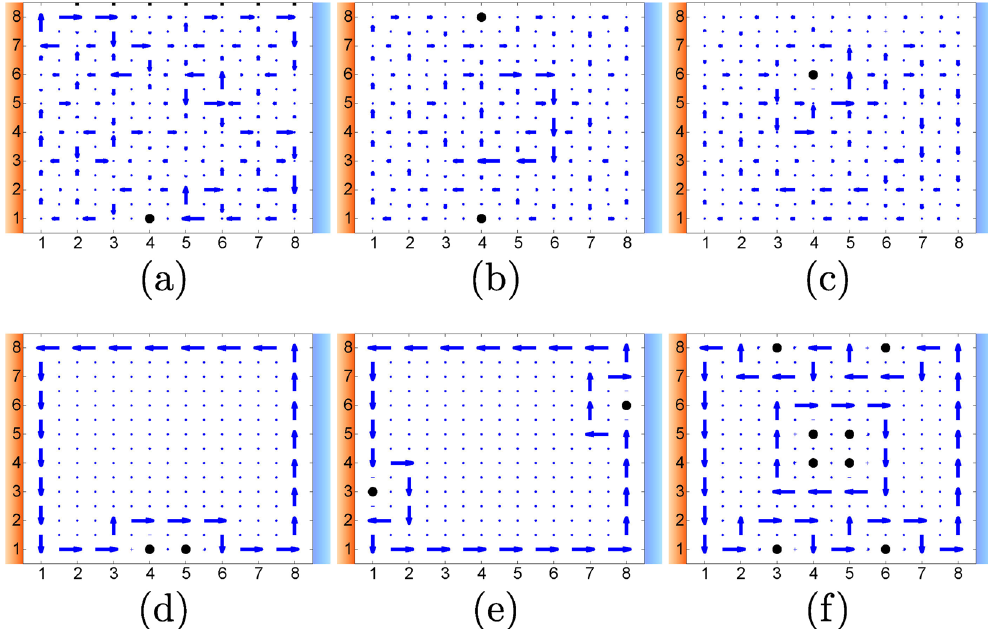
Figure 3. Current patterns for an out-of-equilibrium situation under the presence of defects indicated with a black dot ( T h = 2500 K and T c = 1500 K, similar results are obtained for other values avoiding extremely high and low temperatures, see Fig. 2). In ( a ), ( b ) and ( c ) the distribution of defects respects neither ΘΣ y nor R π symmetries, and the currents become unstable. In contrast, in ( d ), ( e ) and ( f ) the distribution of defects is invariant under ΘΣ y , R π , and both ΘΣ y and R π , respectively, and the currents remain